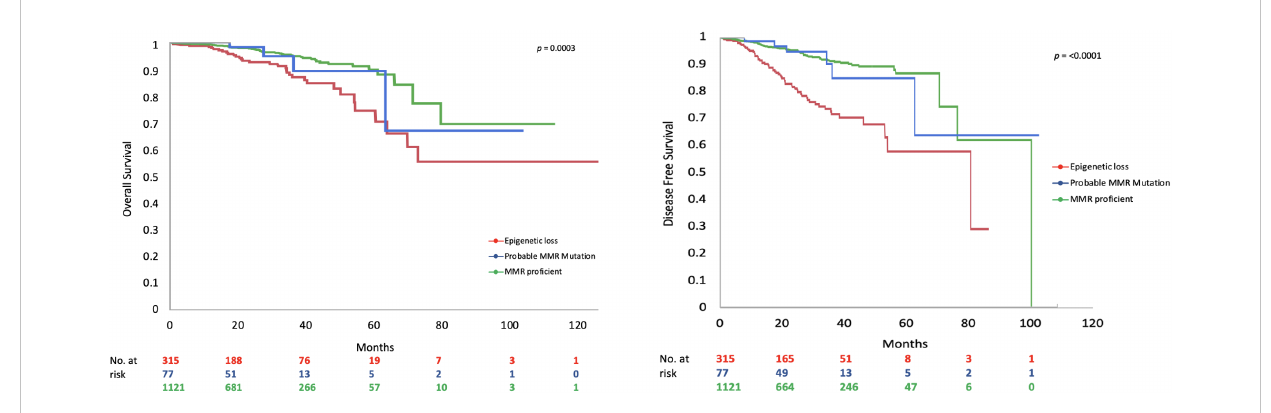
FIGURE 1 Overall survival and disease-free survival by MMR class.